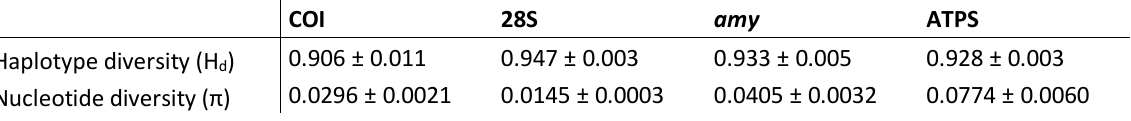
Table 1: Genetic diversity indices: haplotype diversity (H d ) and nucleotide diversity (π) for all Corbicula samples based on COI, 28S, alpha-amylase, and